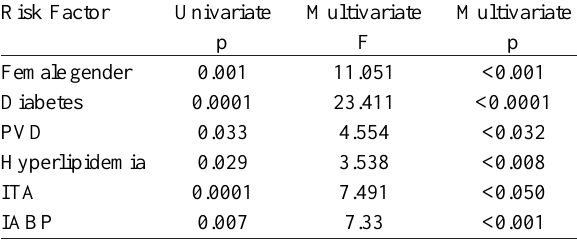
Table4 . Multivariate Analysis of Risk